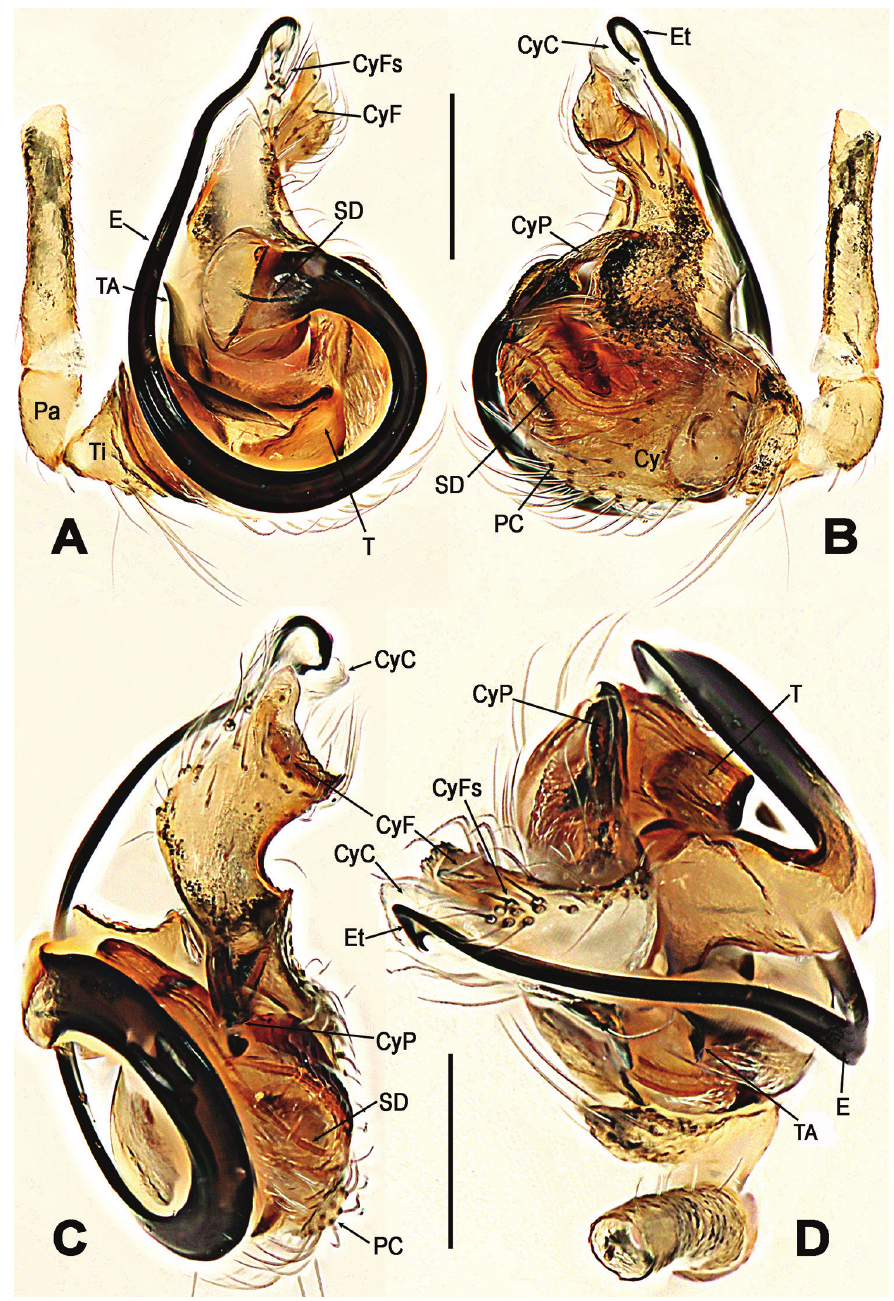
Figure 7. Trogloneta yuensis Lin & Li, 2013, male left palp ( A–D ). A prolateral B retrolateral C apical D ventral. Abbreviations: Cy cymbium; CyC cymbial conductor; CyF cymbial fold; CyFs setae on cym- bial fold; CyP cymbial process; E embolus; Et embolic tip; TA tegular apophysis; Pa patella; PC paracym- bium; SD spermatic duct; T tegulum; Ti tibia. Scale bars: 0.20